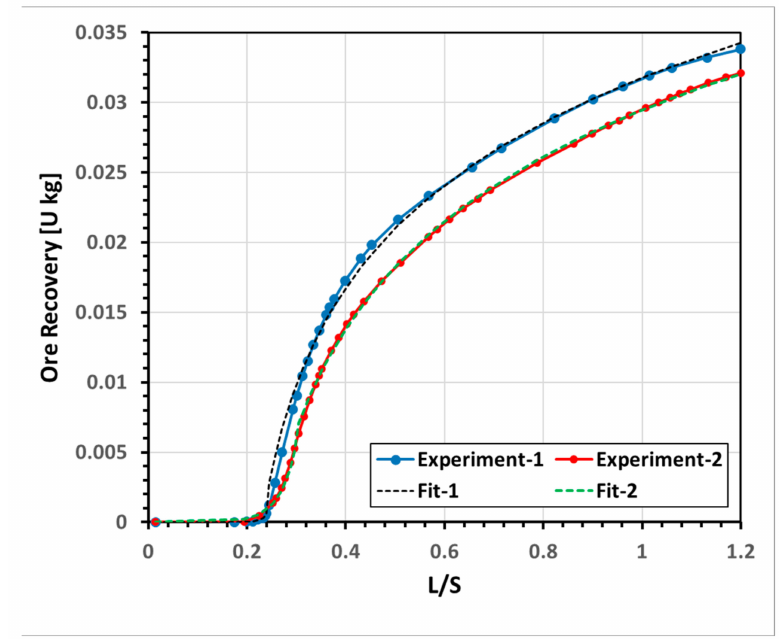
Figure 4. Uranium recovery plotted against L/S ratio based on lab experiments [5] fitted to an analyti- cal bi-compartmental model (see text): experiment 1: H 2 SO 4 = 30 g/L; experiment 2: H 2 SO 4 = 20